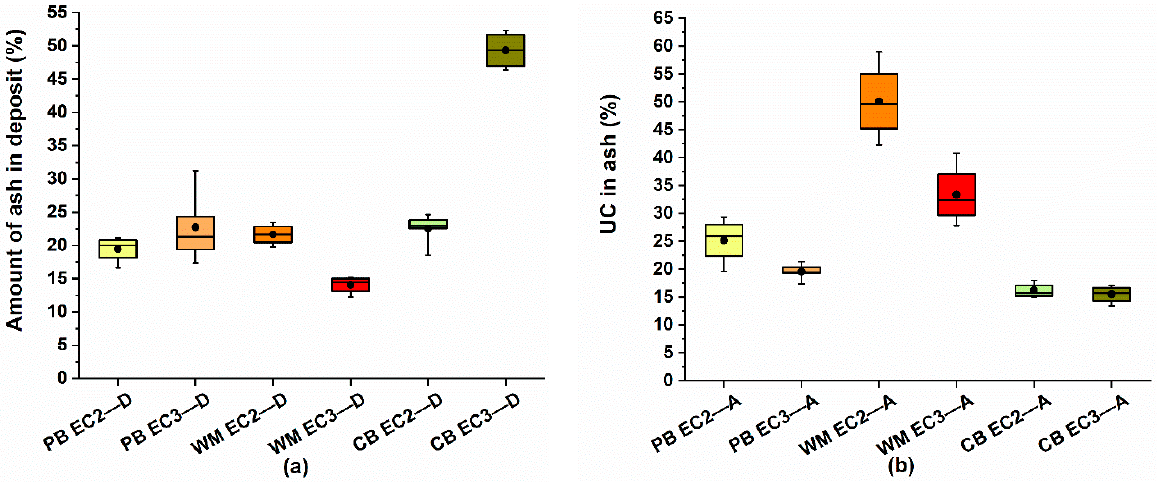
Figure 2. Amounts of inorganic component (ash) in deposits ( a ) and amounts of unburned carbon in deposits ( b ). In this case, when the content of inorganic elements in the input fuel is minimal, the amounts of deposits captured in BEC3 is lower (0.19 ± 0.04 g/kg of fuel) than in BEC2 (0.97 ± 0.16 g/kg of fuel). As a result, only 13.82 ± 1.21% of the inorganic component was cap- tured in the deposits from BEC3, compared to 21.81 ± 1.05% in BEC2. When burning in BEC2, the temperature was probably lower, which did not allow further thermal decom-